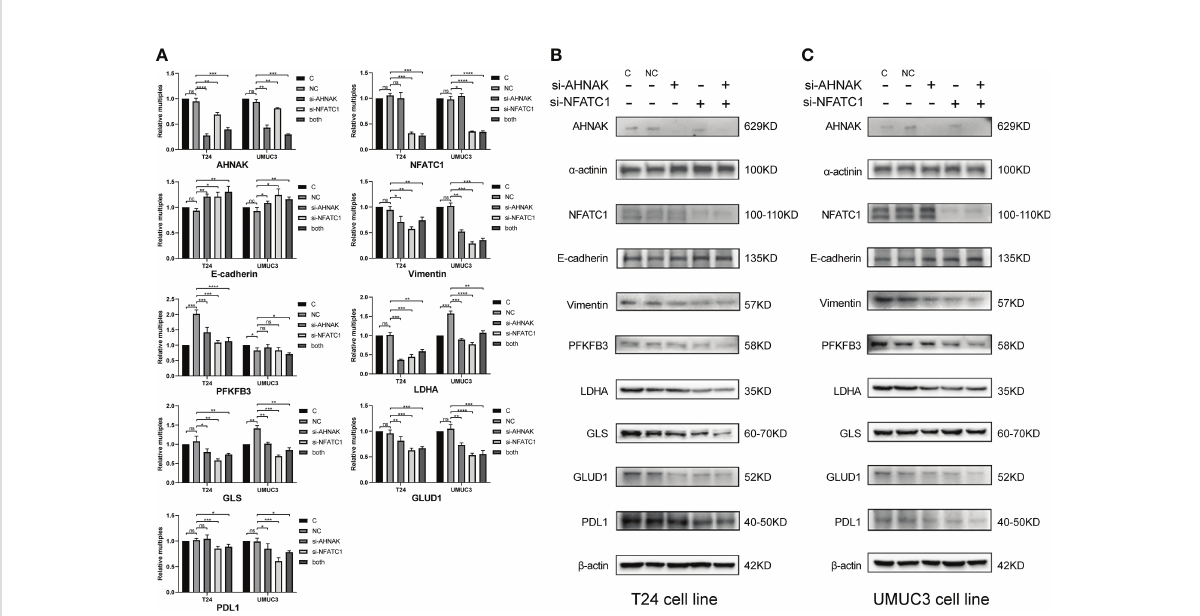
FIGURE 9 qPCR (A) and WB (B, C) were used to detect the effects of AHNAK and NFATC1 knockdown with siRNAs on key glycolysis enzymes, amino acid metabolism enzymes, EMT and PD-L1 immune checkpoints of two bladder cancer cell lines T24 and UMUC3. Glycolysis enzymes involve